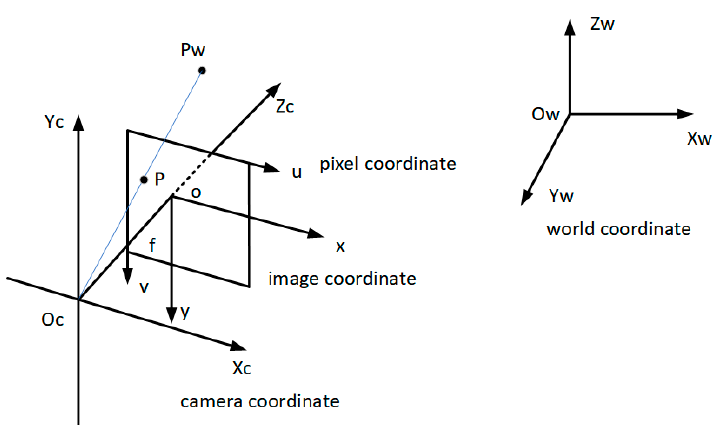
Figure 9. Coordinate system transformation.